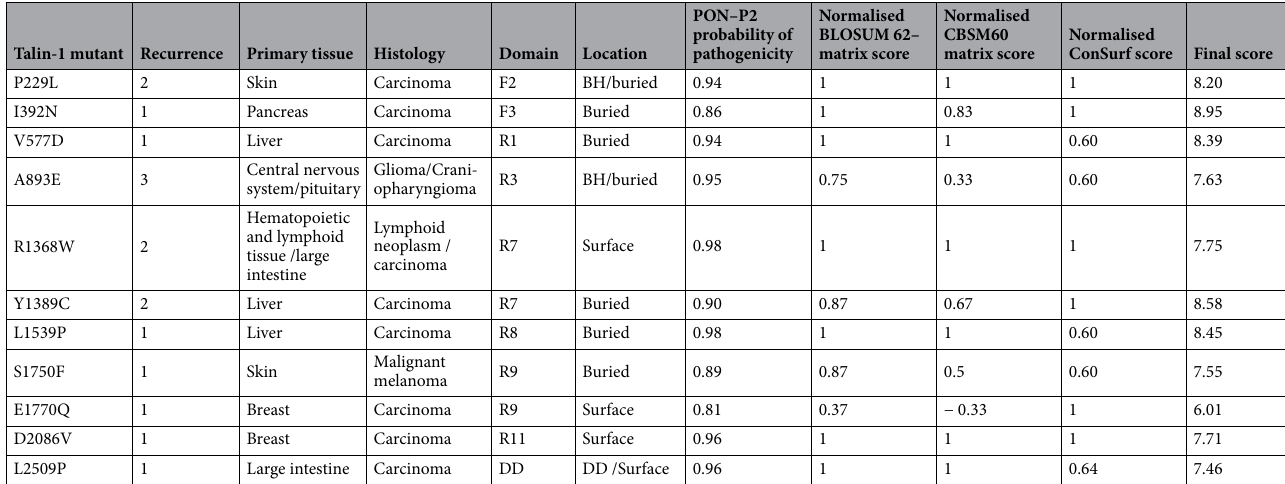
Table 1. The list of talin-1 point mutations selected from the COSMIC database. In each column a normalised value close to 1 predicts defects in protein function. BH mutation located between helices, DD